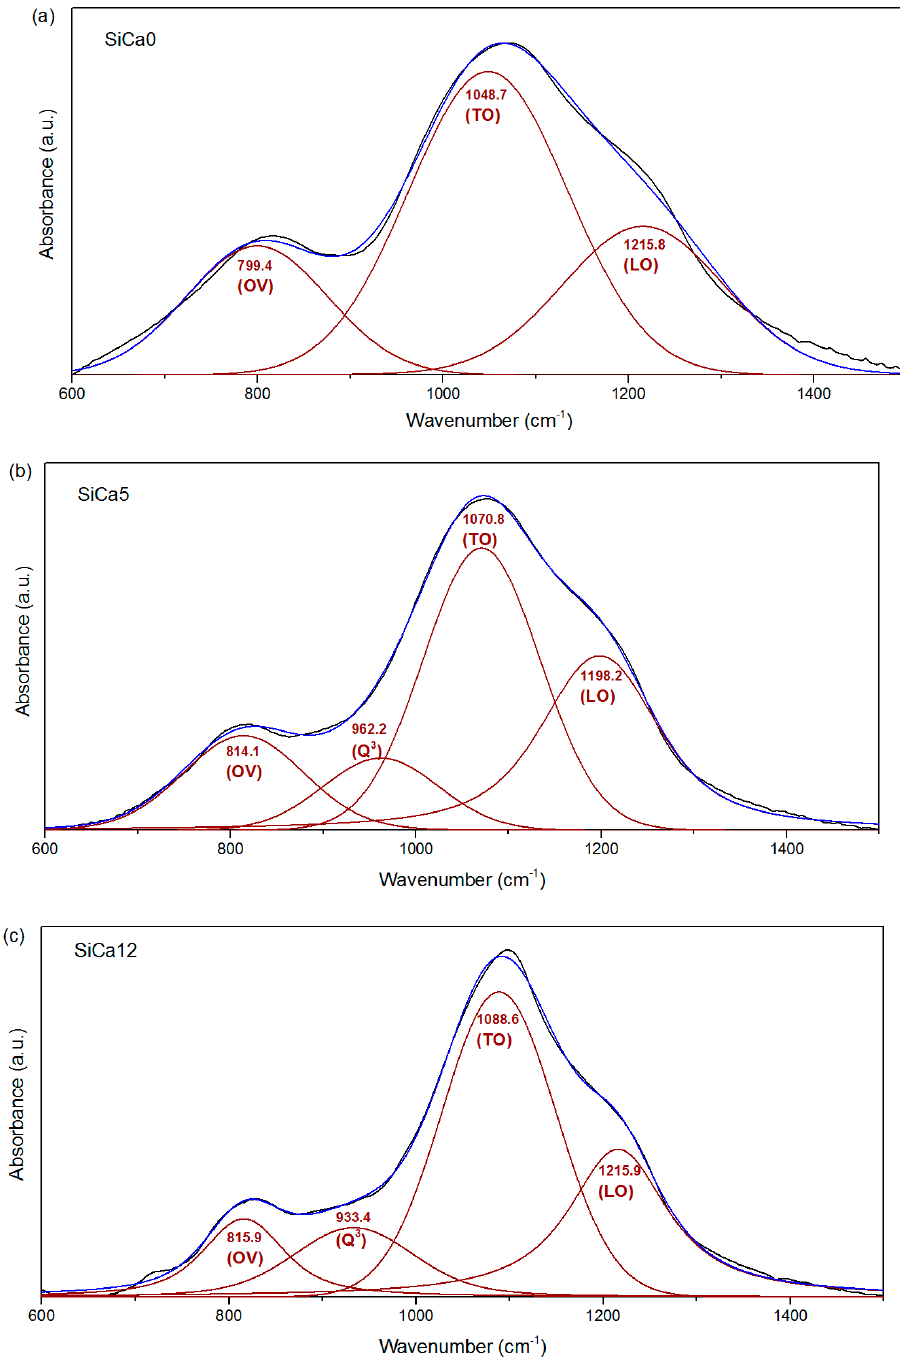
Figure 4. Deconvolution of FTIR spectra (black lines) between 600 cm − 1 and 1500 cm − 1 for ( a ) SiCa0, ( b ) SiCa5, and ( c ) SiCa12 into LO ν (Si–O–Si), TO v(Si–O–Si), overlapping v(Si–O–Si) / v(Si–C) (OV) and Q 3 components (red lines). The sum of all fitted bands yields the blue lines in spectra.